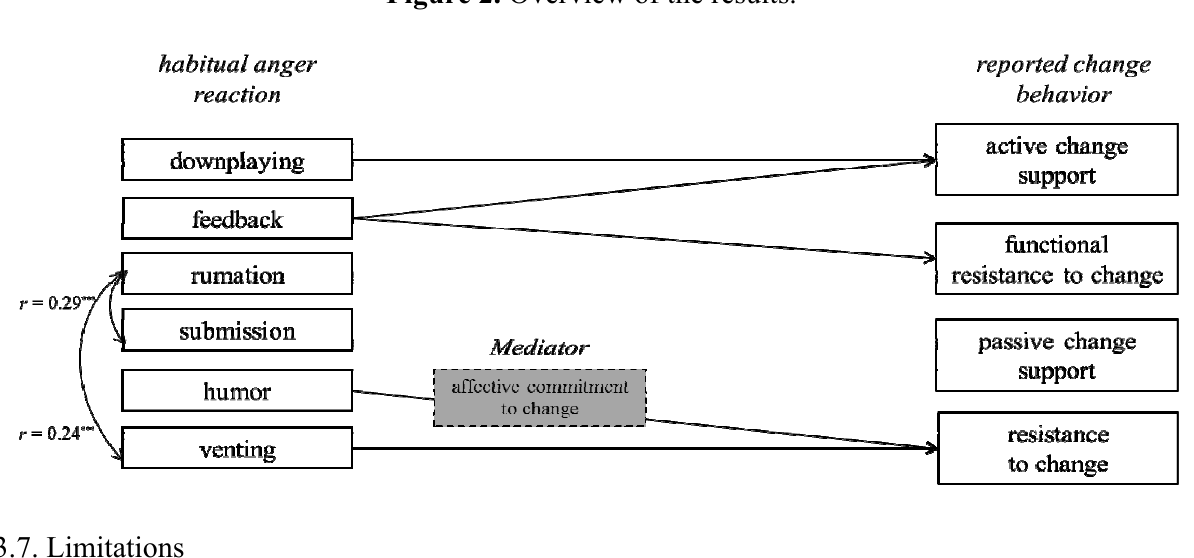
Figure 2. Overview of the